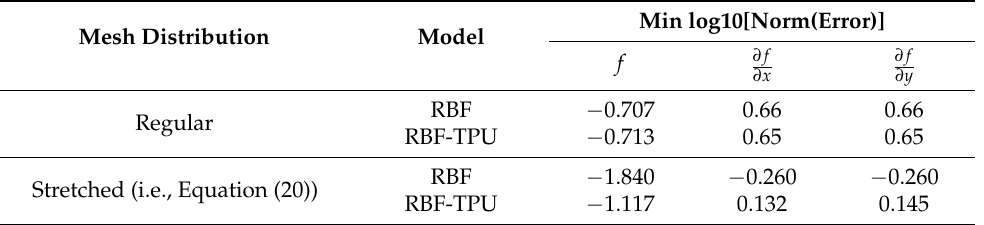
Figure 10. The log10 of the norm of the error of approximating the given function f ( x , y ) and its first derivatives using Gaussian RBF-TPU with zeroth truncation order for a range of ε and m values. The rows are for function, first x-derivative, and first y-derivative approximations. The ε k range is [ − 1, 1] and N e = 5. Table 3. Comparison of the minimum error for approximating derivatives between Gaussian RBF and RBF-TPU for the 2D case (Equations